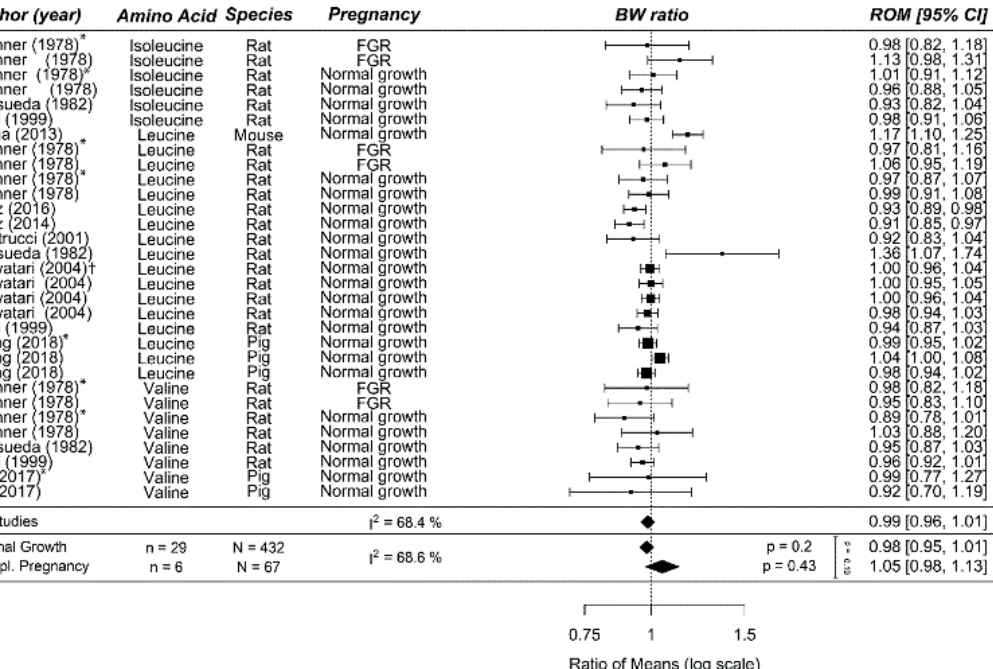
Figure A9. Meta-analysis on prenatal supplementation of branched chain amino acid on fetal/birth weight (BW). Prenatal branched chain amino acid supplementation did not affect birth weight, neither in normal growth pregnancies nor in complicated pregnancies. Data is ordered within each amino acid (AA) from smallest to largest animal. Data represent pooled estimates expressed as ratio of means (ROM) with 95% confidence interval (CI) using a random effect model. Residual I 2 is shown. Some studies had multiple cohorts and are distinguishable in this figure by: * in this upper line the daily dose is lower compared the next line(s) in increasing order; †the upper two lines are in the lower dose compared to the next two lines and per dose the outcomes is separately reported for males first and then females. FGR, fetal growth restriction; I 2 , heterogeneity.